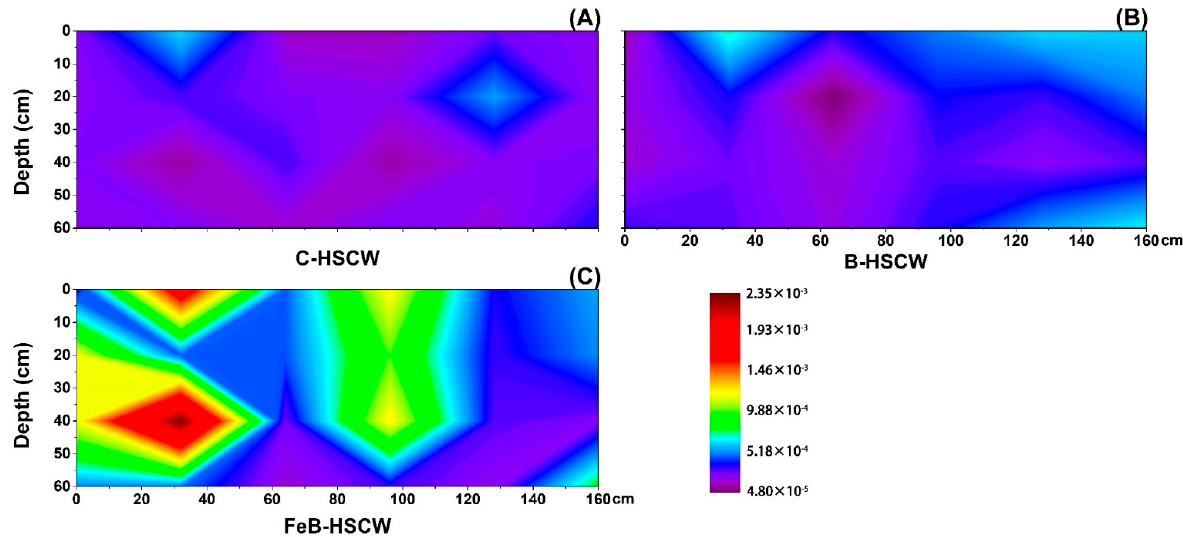
Figure 9. The spatial distribution of cnorB relative abundance in C-HSCW ( A ), B-HSCW ( B ), and FeB-HSCW ( C ) based on interpolated maps. Color scales indicate extrapolated values by kriging. C-HSCW, without biochar and FeB-modified bi- ochar; B-HSCW, with biochar; FeB-HSCW, with FeB-modified biochar.